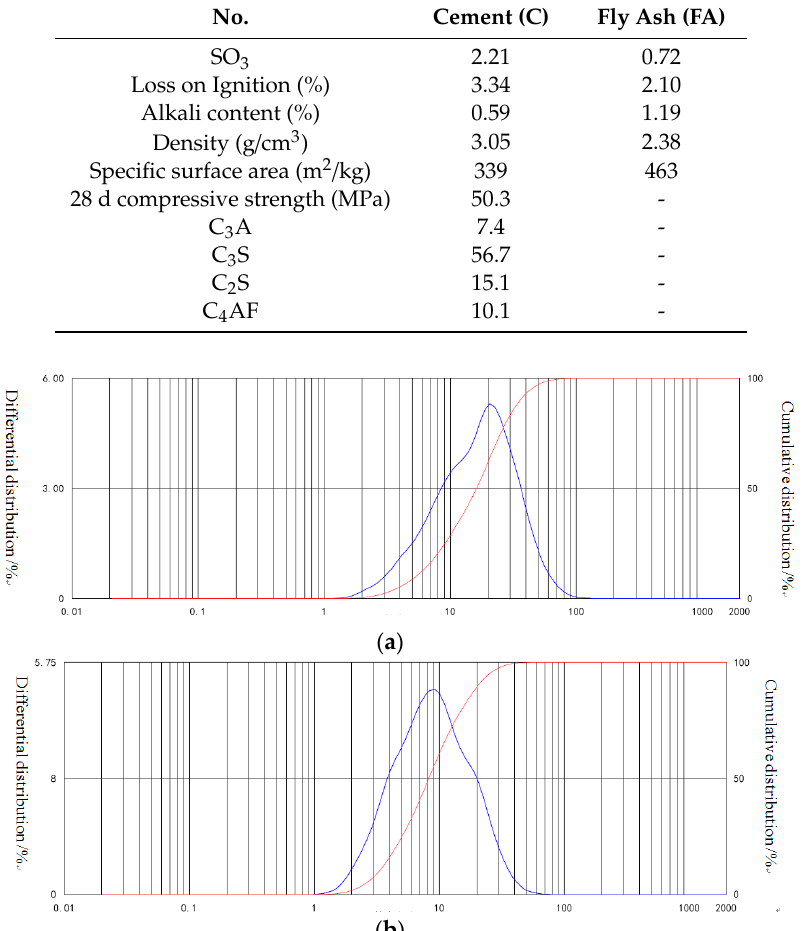
Table 2. Chemical and physical properties of cement (C) and fly ash (FA).